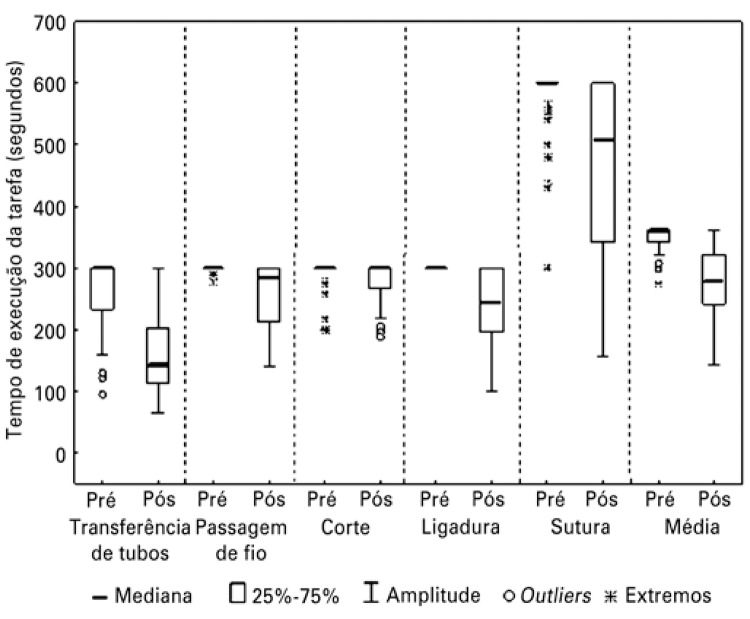
Tempo de execução de exercícios por estudantes de Medicina, no pré e pós-treinamento, em simulador cirúrgico laparoscópico